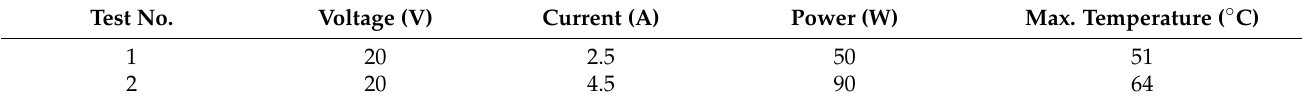
Table 6. Results from heating test for the rolled sample.